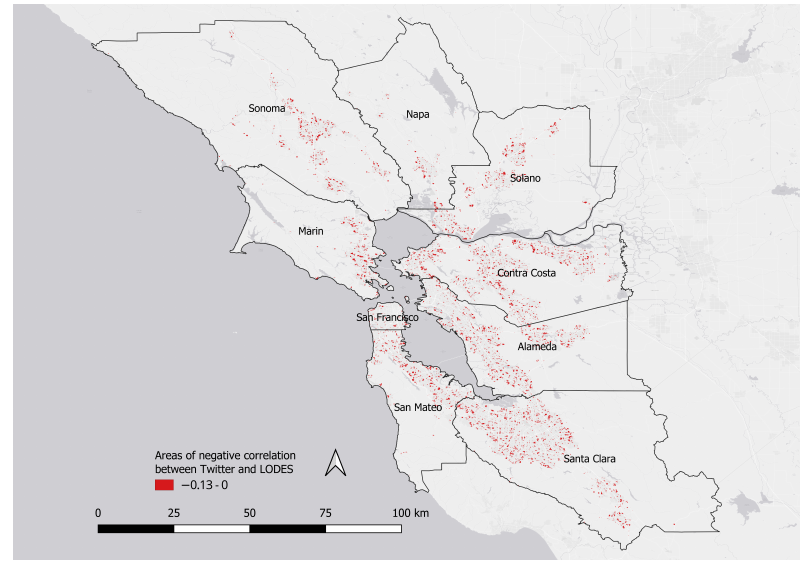
Figure 9. Areas with a (mildly, up to − 0.13) negative r 2 for Twitter data predicting LODES street segment use. The areas in red are the only areas, where there is a significant difference for all the tweets that were filtered for the purpose of simulating LODES data. The total sum of these areas is small and not spatially